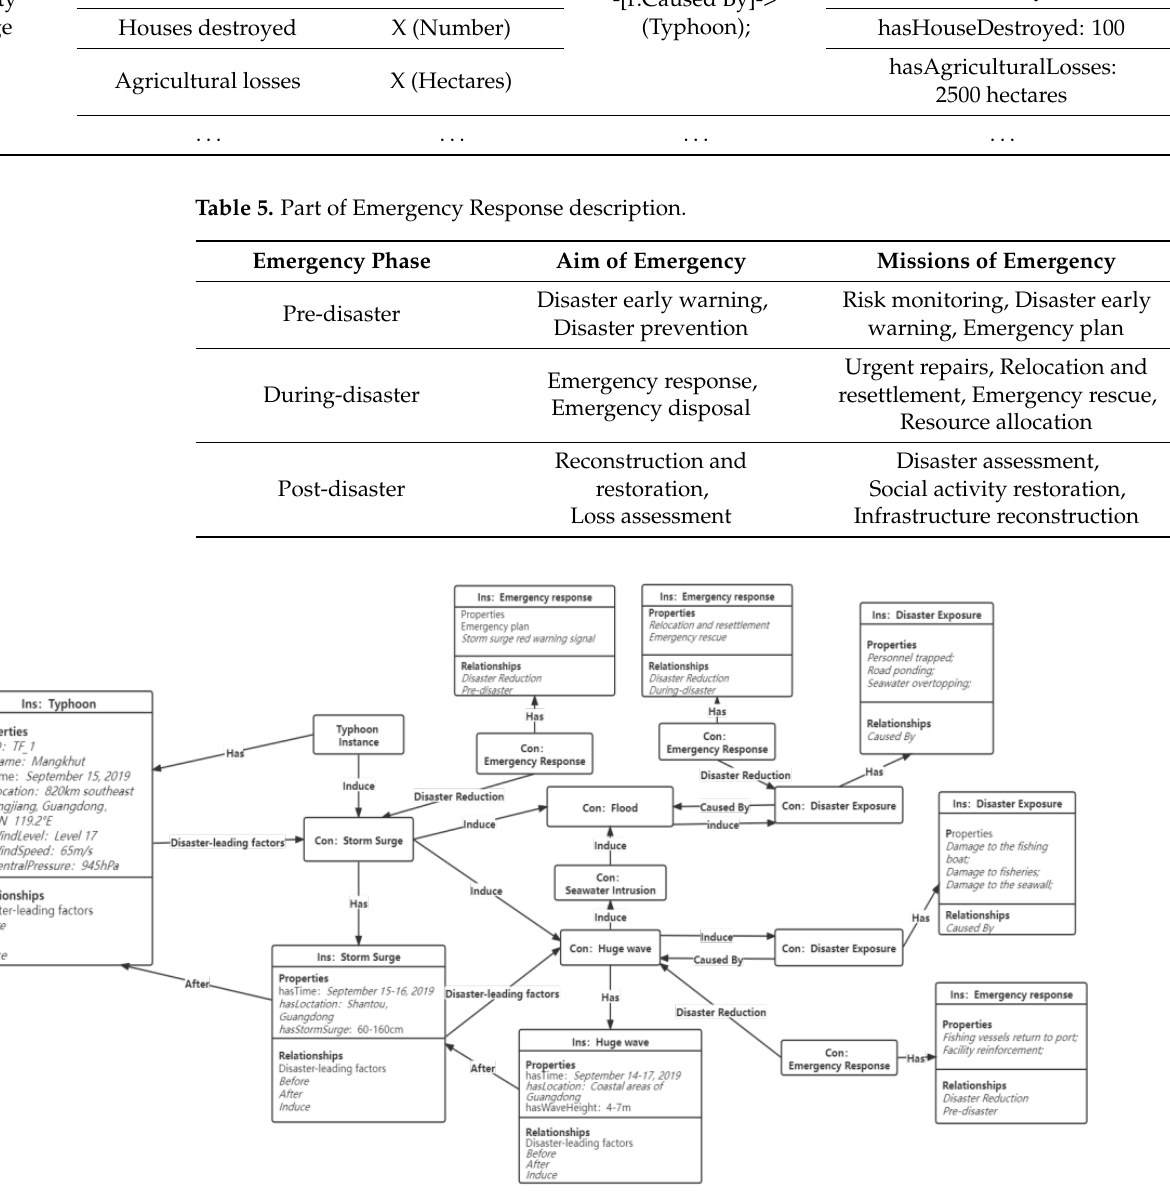
Figure 6. Part of the Typhoon Disaster Chain Ontology Model (TDCOM) structure.